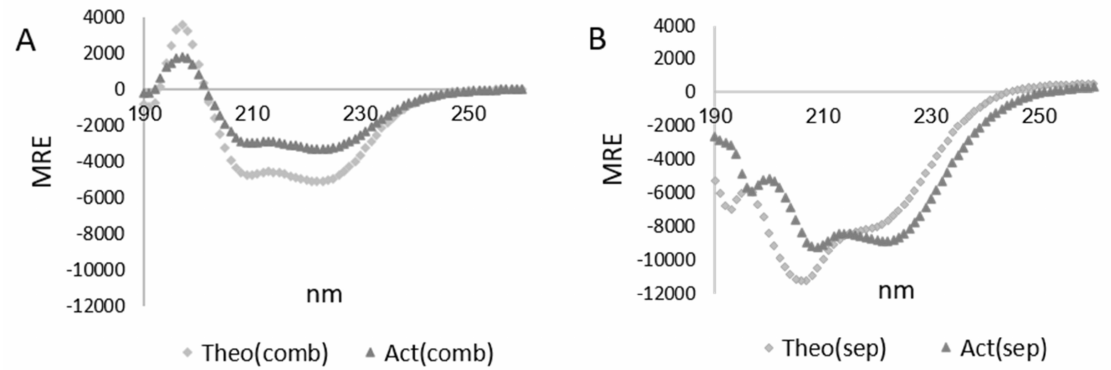
Figure 4. Comparison of MRE methods for experimentally combined WYR and LMM (Act) and projected non-binding profiles (Theo). ( A ) Comparison of Act and Theo using the Combined (comb) method for MRE calculation. ( B ) Comparison of Act and Theo using the Separate (sep) method for MRE